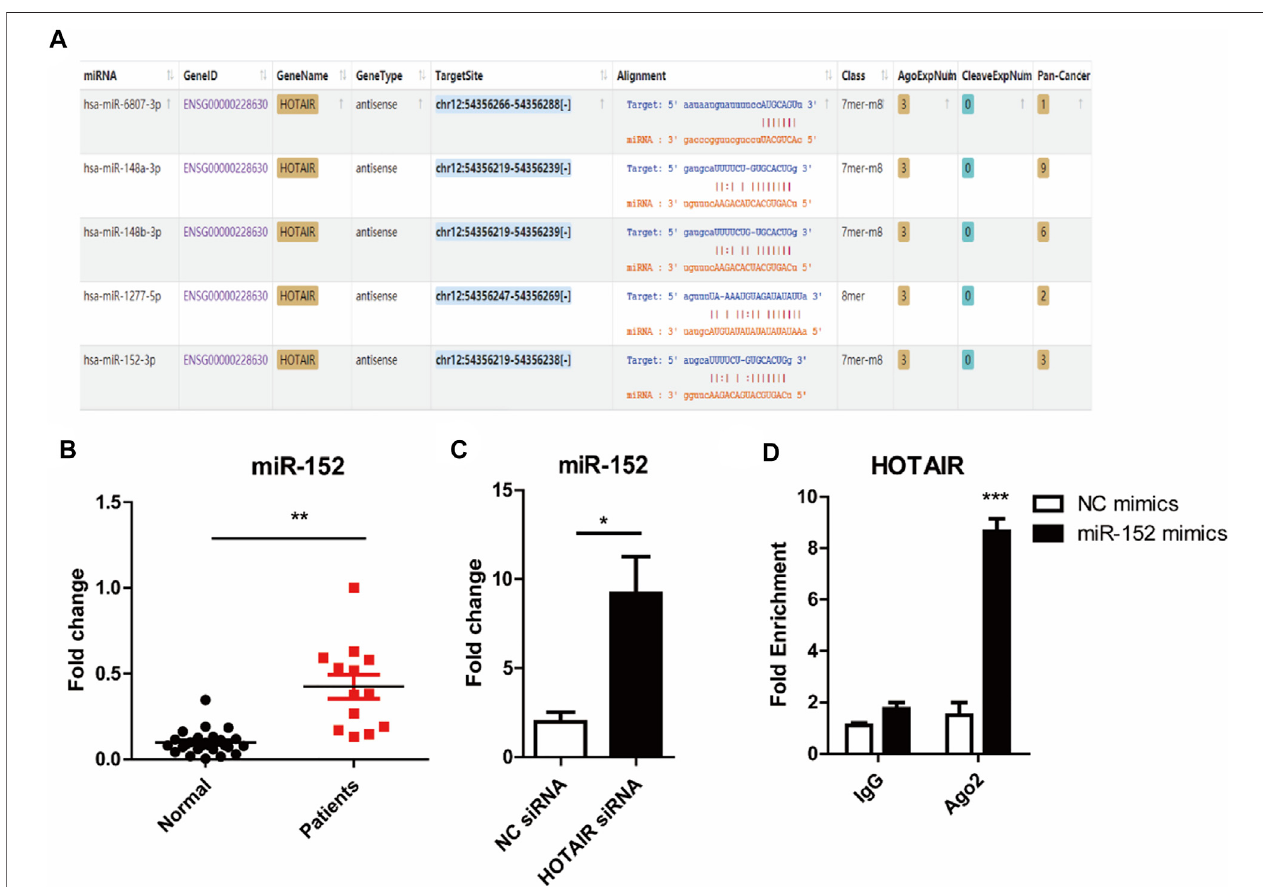
FIGURE4| HOTAIRactsasaspongetoinhibitmiR-152expression (A) PotentialbindingdomainsbetweenHOTAIRtranscriptandmiRNAsthroughBioinformatics analysis using starbase Tools. The sequence alignments were visualized following the instruction on https://starbase.sysu.edu.cn/starbase2/index.php (B) Detection of miR-152 expression in PBMCs of patients with craniosynostosis, compared to control. p < 0.01 (Student ’ s t-test) were considered statistical signi fi cant (C) RT-qPCR analysis of miR-152 expression levels in RANKL-induced osteoclasts with HOTAIR knockdown by two distinct shRNAs (D) RIP analyses of HOTAIR and miR-152 interaction in RANKL-induced osteoclast with miR-152 mimics or NC transfection (100 nM); RT-qPCR detected the mRNA levels HOTAIR; Bars represent the mean ± SD. * p < 0.05, ** p < 0.01, *** p < 0.001. The data are representative of three independent experiments.